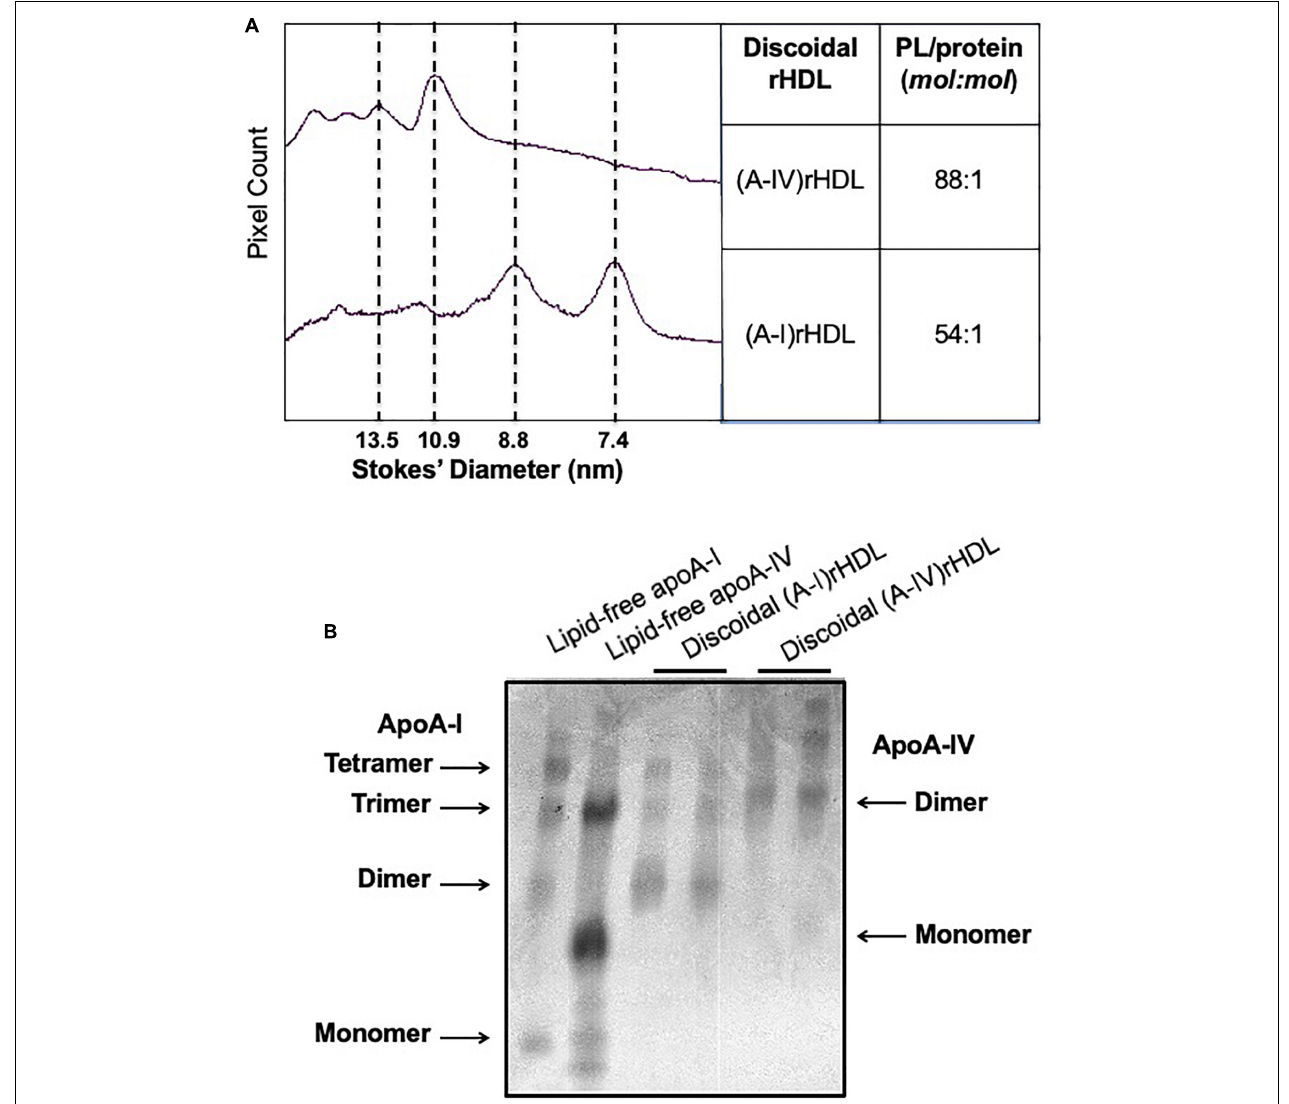
FIGURE 3 | Size and composition of discoidal (A-IV)rHDLs and discoidal (A-I)rHDLs. Discoidal (A-IV)rHDLs and (A-I)rHDLs were prepared by the cholate dialysis method and analysed in terms of size and composition [Panel (A) ]. The discoidal rHDLs were then cross-linked with BS and their migration was compared with that of cross-linked lipid-free apoA-I and apoA-IV [Panel (B) ].